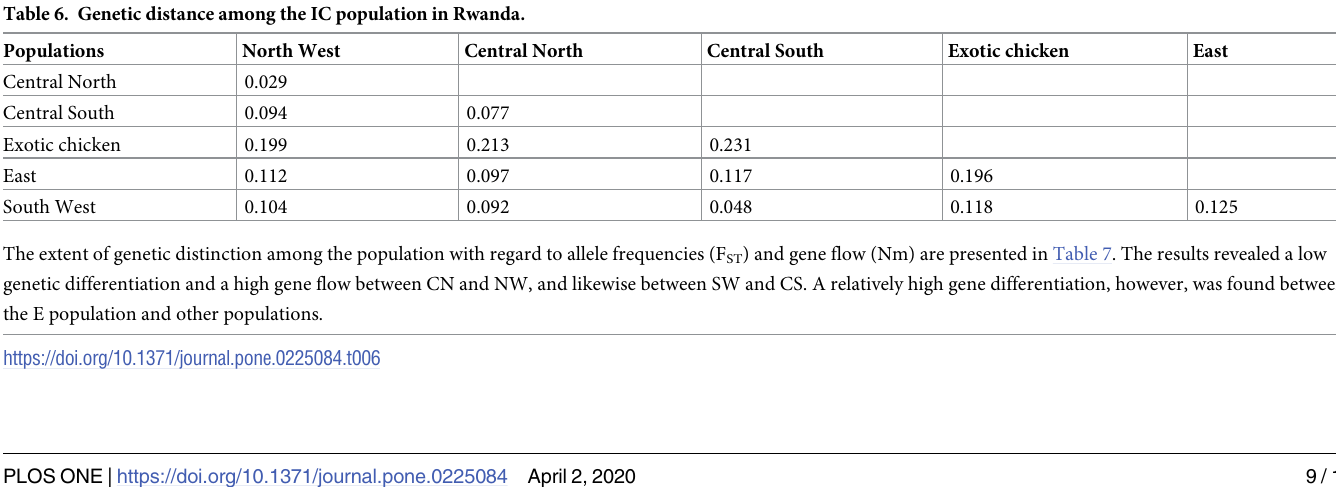
Table 6. Genetic distance among the IC population in Rwanda.